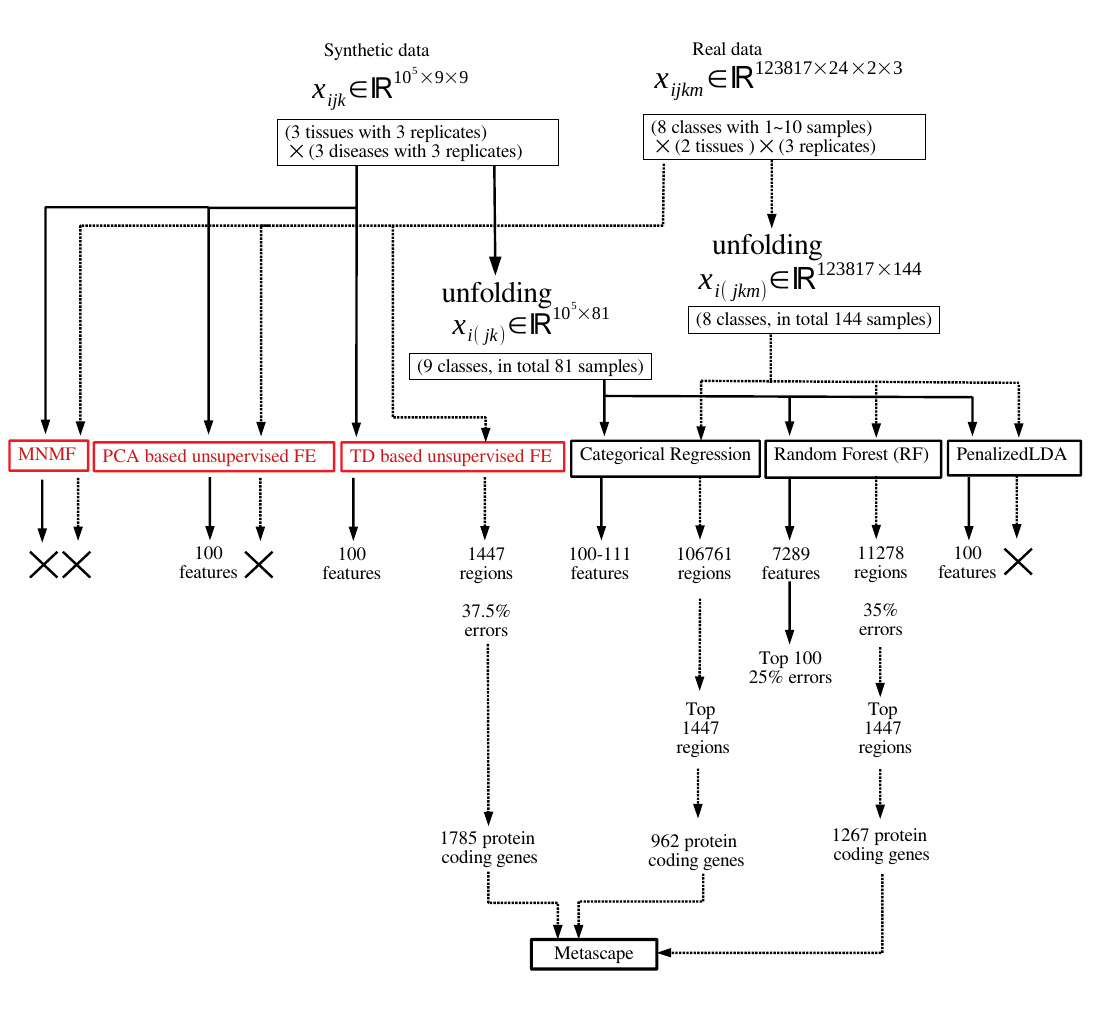
Figure 1. Flowchart of analyses performed in this study. Those in red and black are unsupervised and supervised feature selection, respectively. × means that no regions or features can be